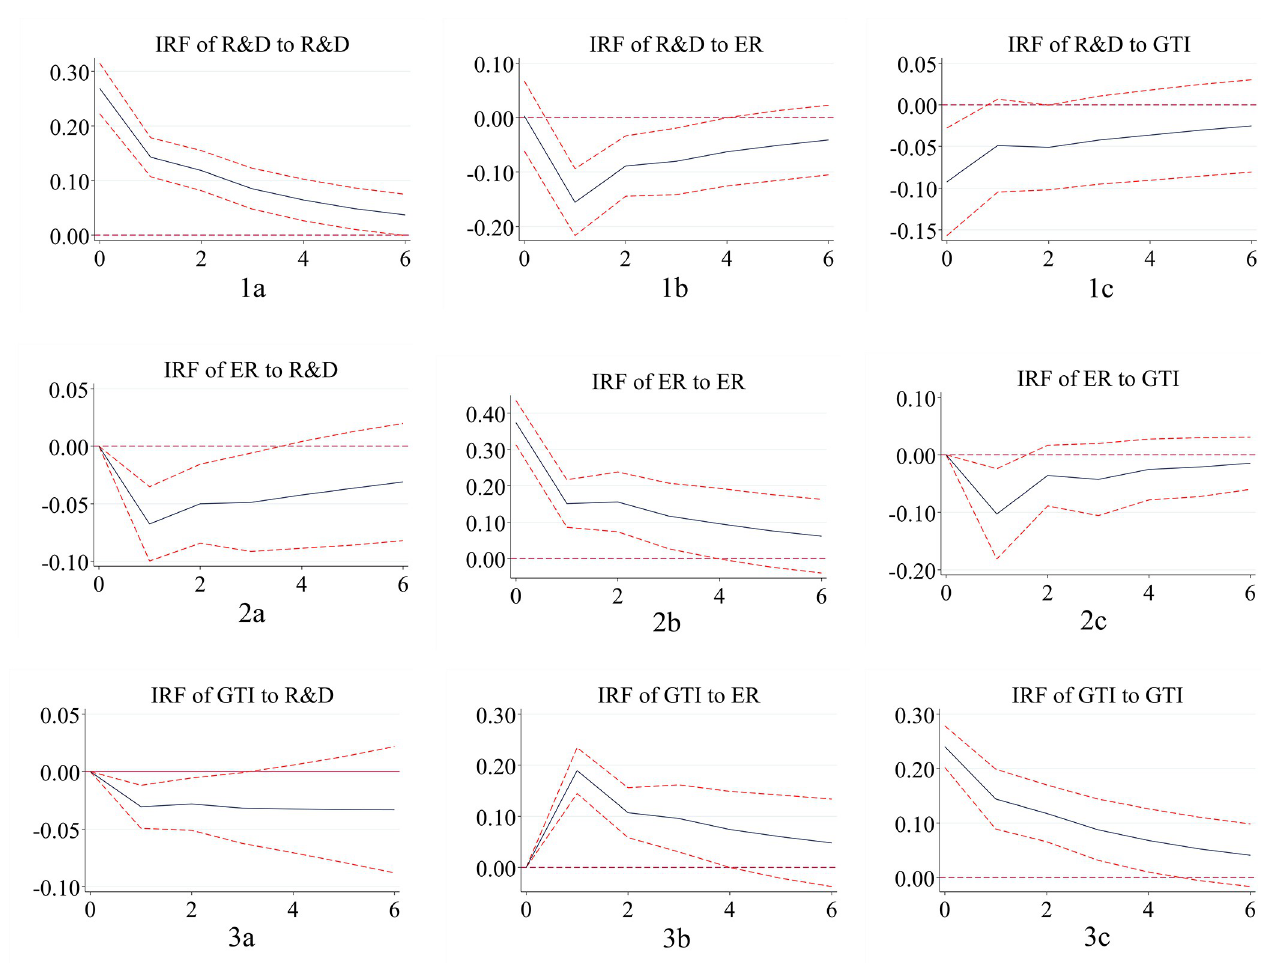
Fig 2. Impulse response in central China. Notes: The horizontal axis represents the number of lag periods (years), the middle curve is the impulse response function curve, and the upper and lower curves represent the 95% confidence interval.